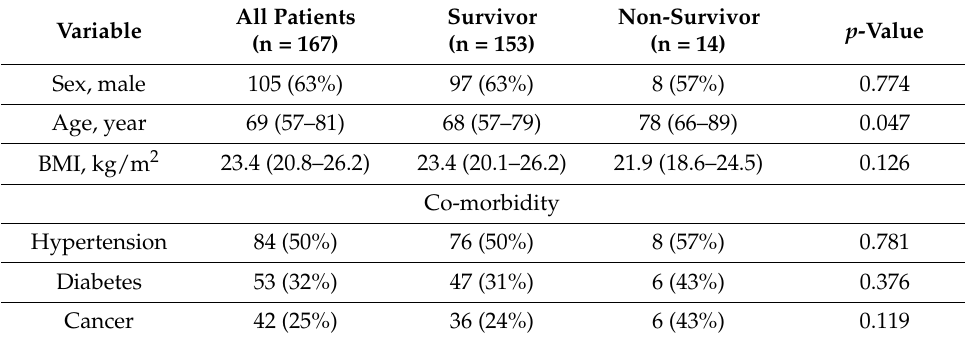
Table 1. Clinical characteristics of patients with nosocomial COVID-19 (n = 167).